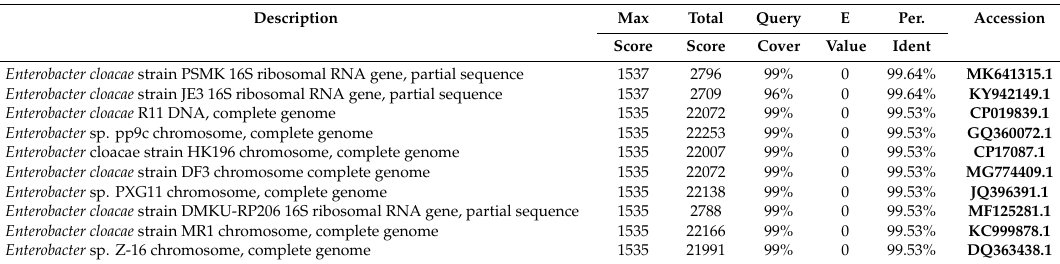
Table 1. The similarity of the isolate BRC05 16S rRNA gene sequence of the top ten Blast search result together with the 16S rRNA gene sequence of bacterium BRC05 and closely related species from the NCBI